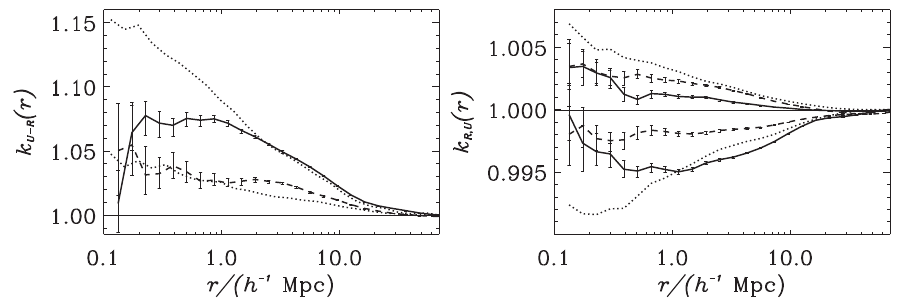
Fig. 5. Left panel: Mark correlation function using the U (cid:0) R color as mark for samples m1 (solid line) and m6 (dashed line) in comparison with mock samples given by the F08 model (dotted lines). Right panel: Mark correlation function using the U -band ( k U < 1) and R -band ( k R > 1) absolute magnitudes as mark for samples r1 (solid line) and r3 (dashed line) in comparison with mock samples given by the F08 model (dotted lines). For clarity, mock galaxies here are only compared with sample r1. Errors are one standard